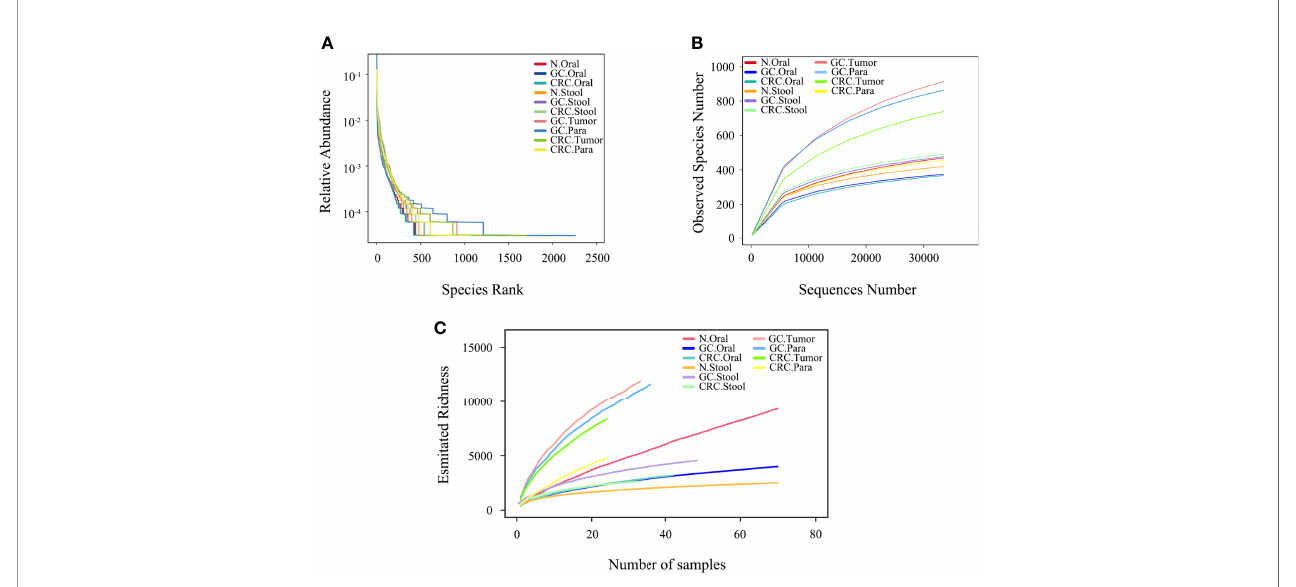
FIGURE 2 | Microbial diversity in each group. (A) The evenness of the ten microbiota groups was assessed by graded abundance curve. (B) The accumulation curve between the sequencing depth of ten samples and the number of observed species. (C) The accumulation curve between ten samples and estimated